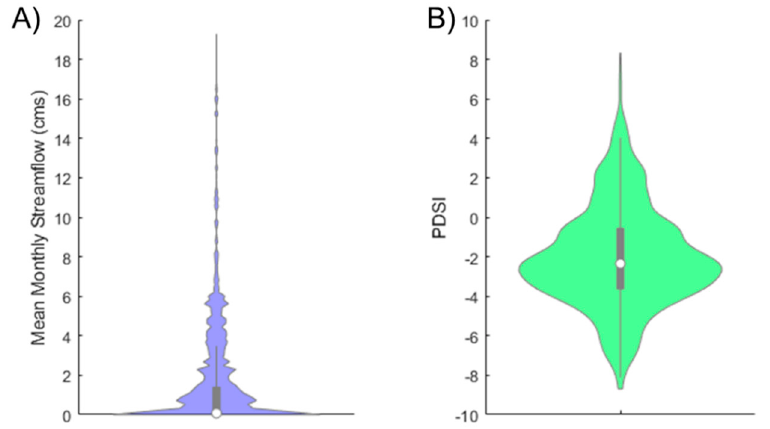
Figure 13. Violin plots (probability distribution) of mean monthly streamflow ( A ) and PDSI ( B ) when FrcSA is zero at co-located reaches. The sample size for the plots is 2060.